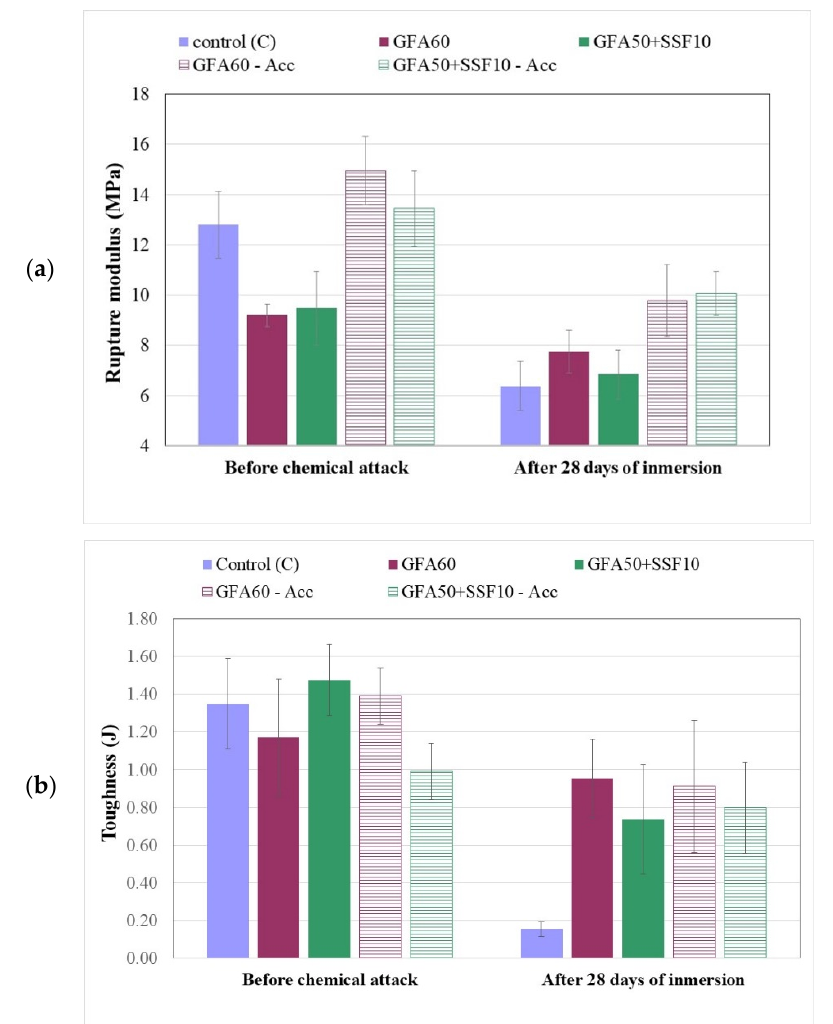
Figure 12. Modulus of rupture ( a ) and toughness ( b ) for the GRC composites immersed in a 1 M NH 4 Cl solution.